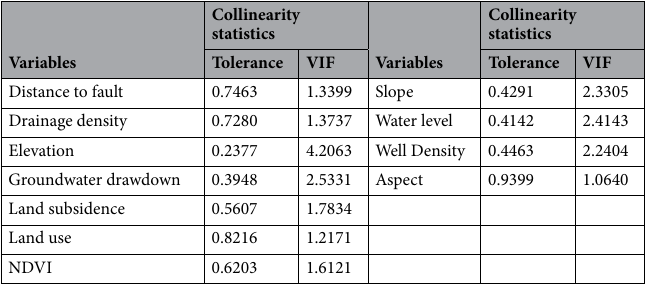
Table 2. Multicollinearity of earth fissure conditioning